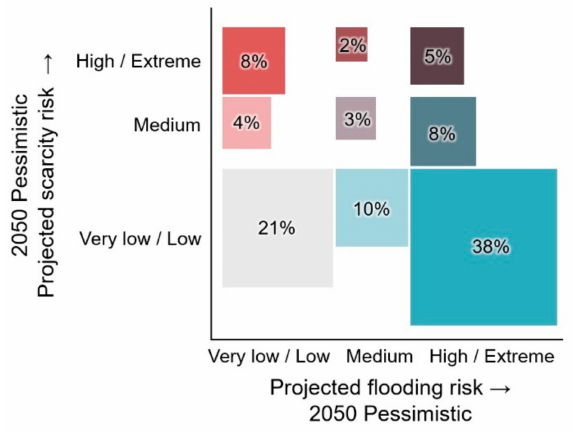
Figure 11. Interaction of projected water scarcity risk and projected flood risk, under the 2050 pessimistic scenario for all dams in this study (existing and projected).